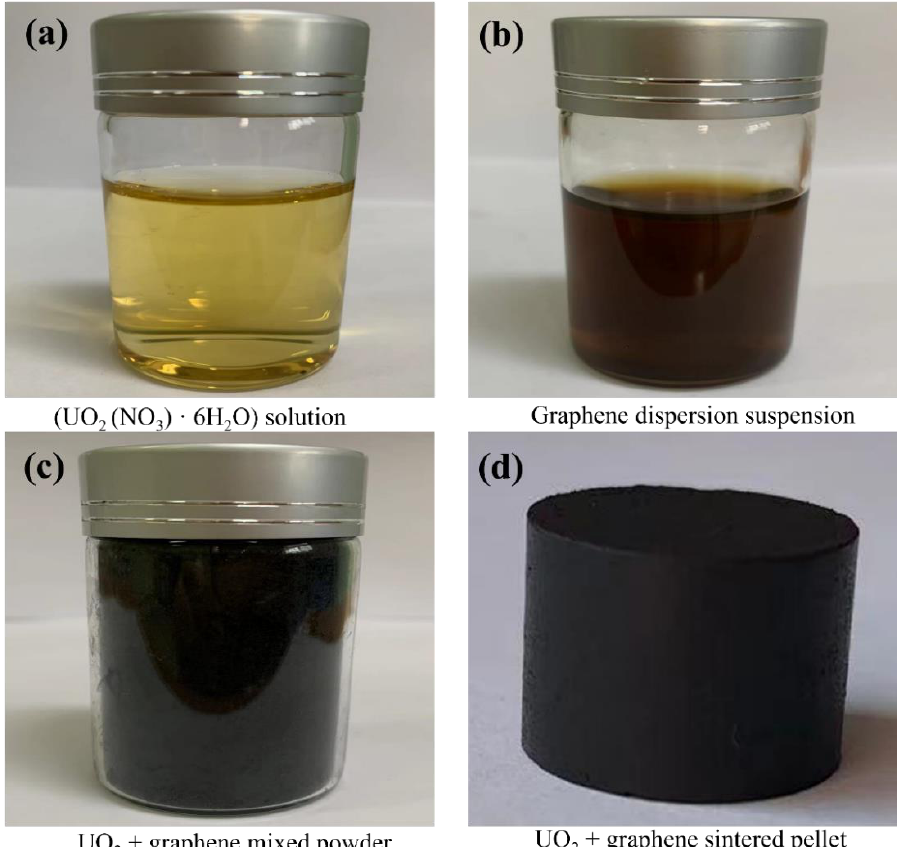
Figure 1. Experimental steps ( a ) (UO 2 (NO 3 ) · 6H 2 O) solution, ( b ) Graphene dispersion suspension, ( c ) UO 2 + graphene mixed powder, and ( d ) UO 2 + graphene sintered pellet for the preparation of UO 2 –graphene composite powder by in situ synthesis.